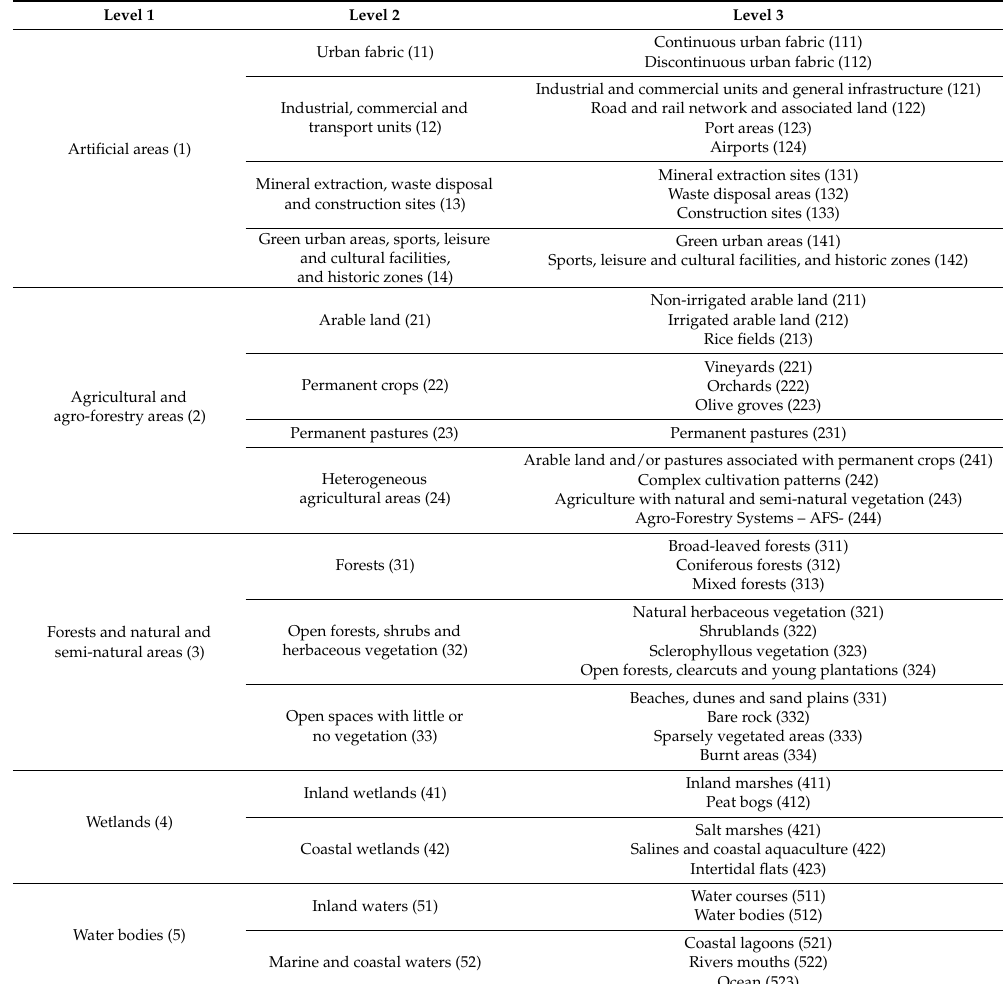
Table A1. COS and CLC Nomenclature: Levels 1, 2 and